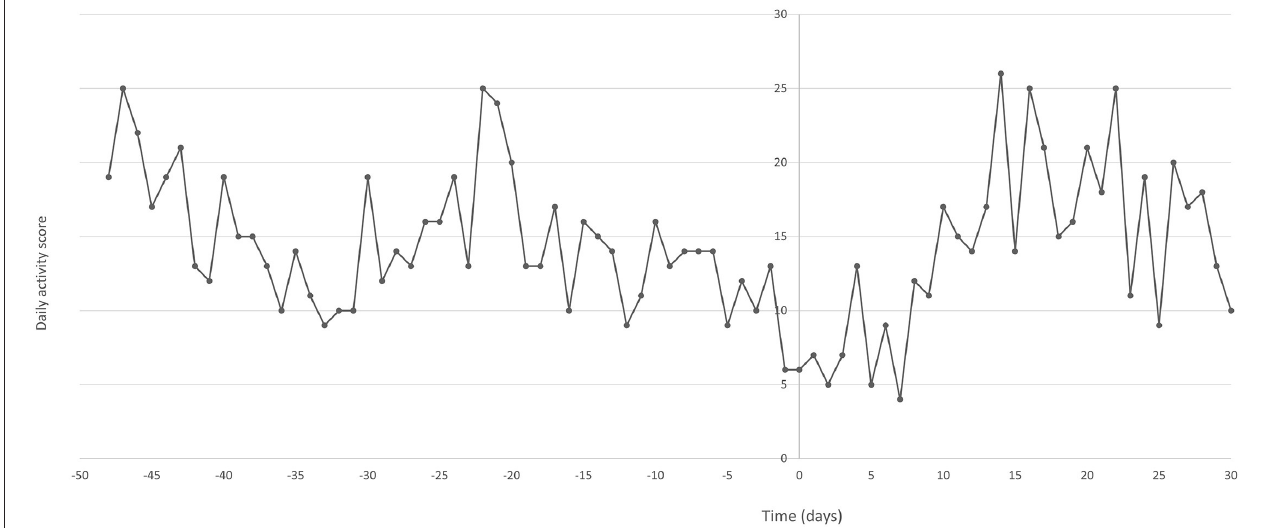
FIGURE 1 | Daily average activity scores collected via an activity monitoring collar (PetPace) from a 14-year-old dog suffering from bilateral hip and elbow osteoarthritis and severe neck pain, before and after liposomal cannabidiol (CBD) subcutaneous injection. X-axis represents days before (negative) and after (positive) liposomal CBD injection on day